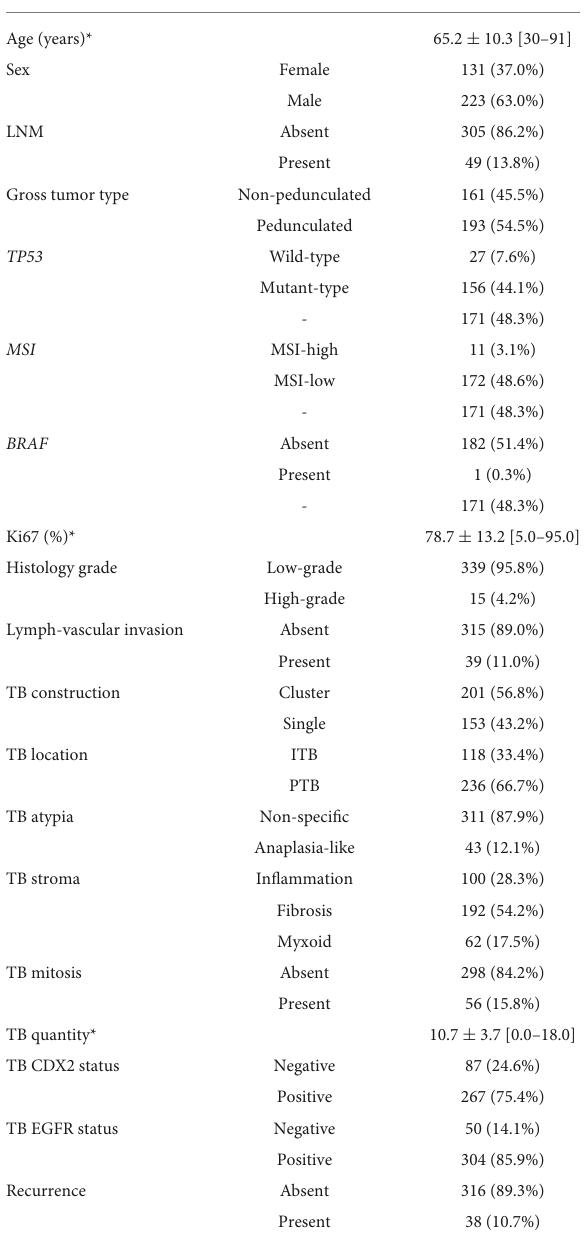
TABLE 1 Demographics of surgery of 354 patients with pT1 CRC who underwent surgical resection. Variable All